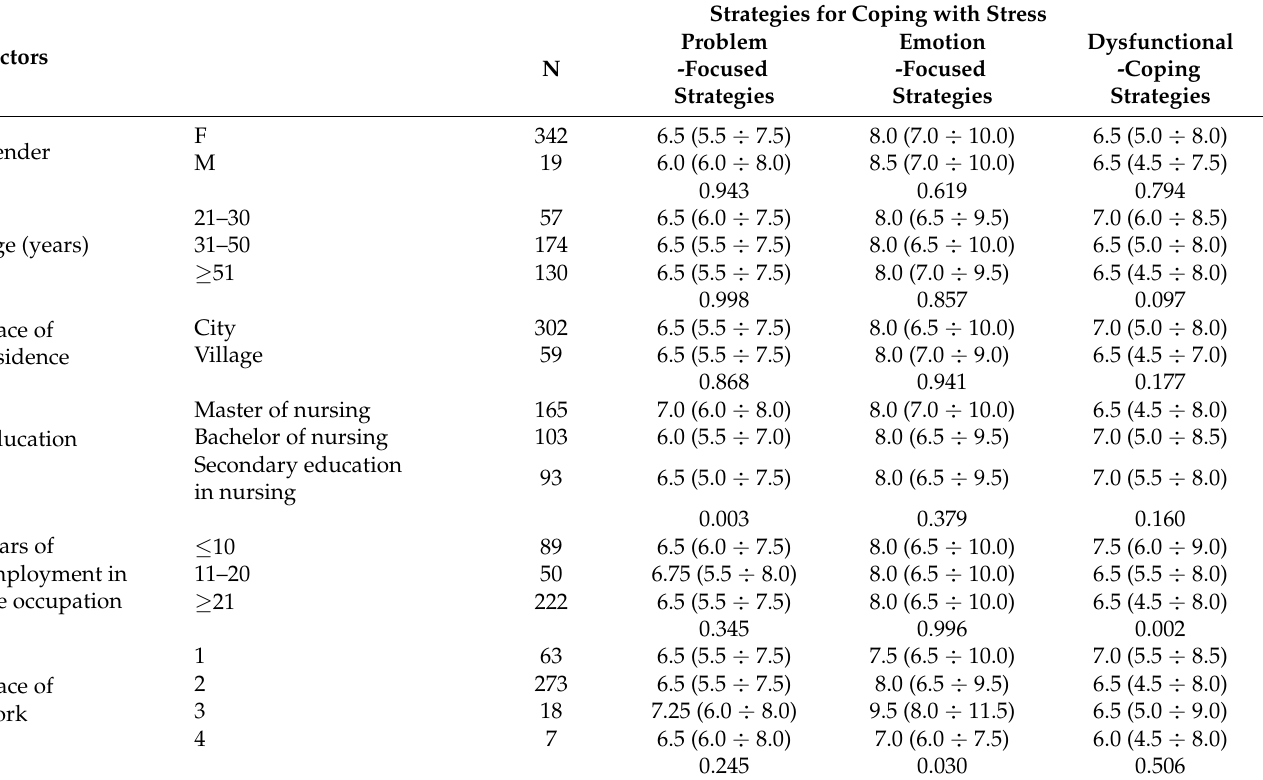
Table 4. Influence of various factors on strategies of coping with